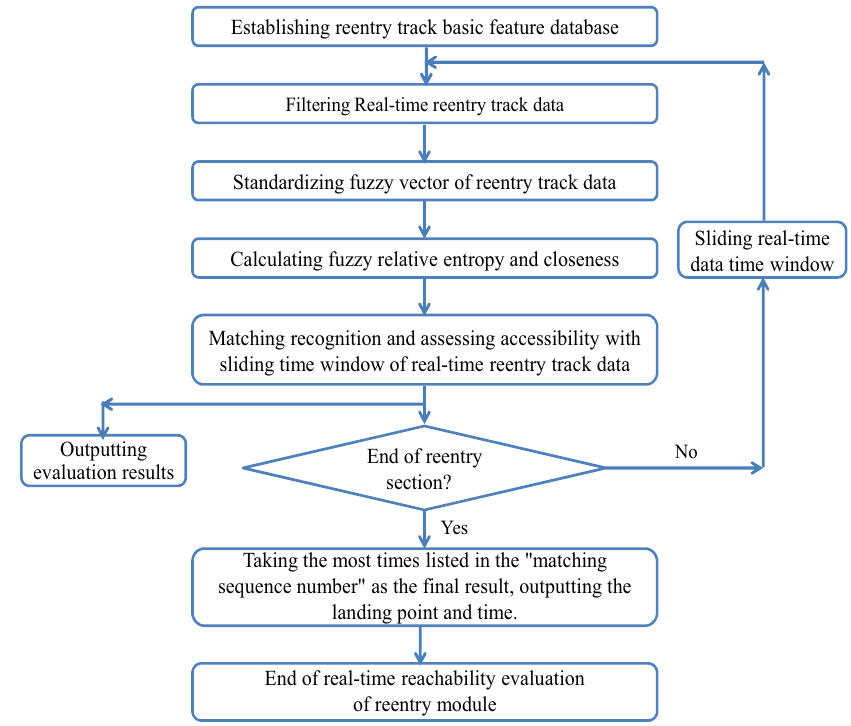
Figure 1: Flowchart of reentry reachability evaluation method for reentry